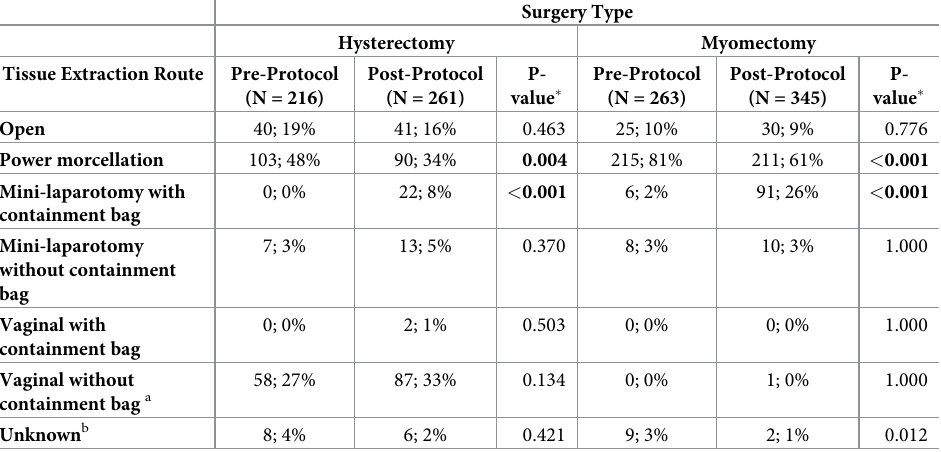
Table 5. Comparison of surgeries, associated routes and tissue extraction techniques by type of surgery in pre- and post-protocol